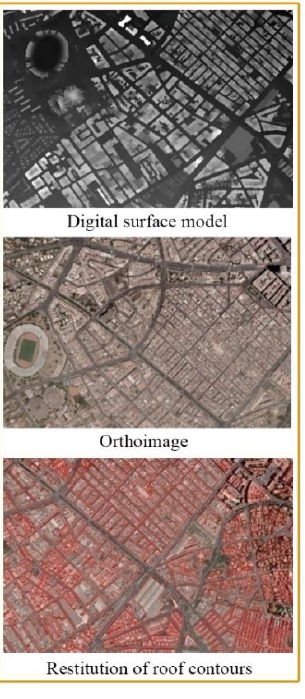
Figure 3. Example of photogrammetric results obtained from acquired